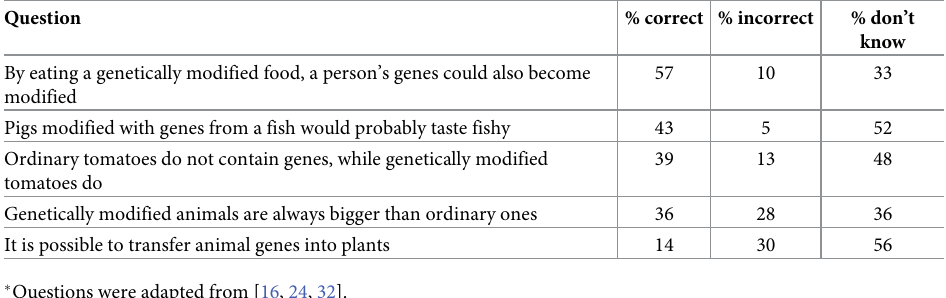
Table 6. Reasons presented by participants to justify their position regarding the use of gene editing technology to reduce boar taint in pigs. Data are shown as % participants in each group � .